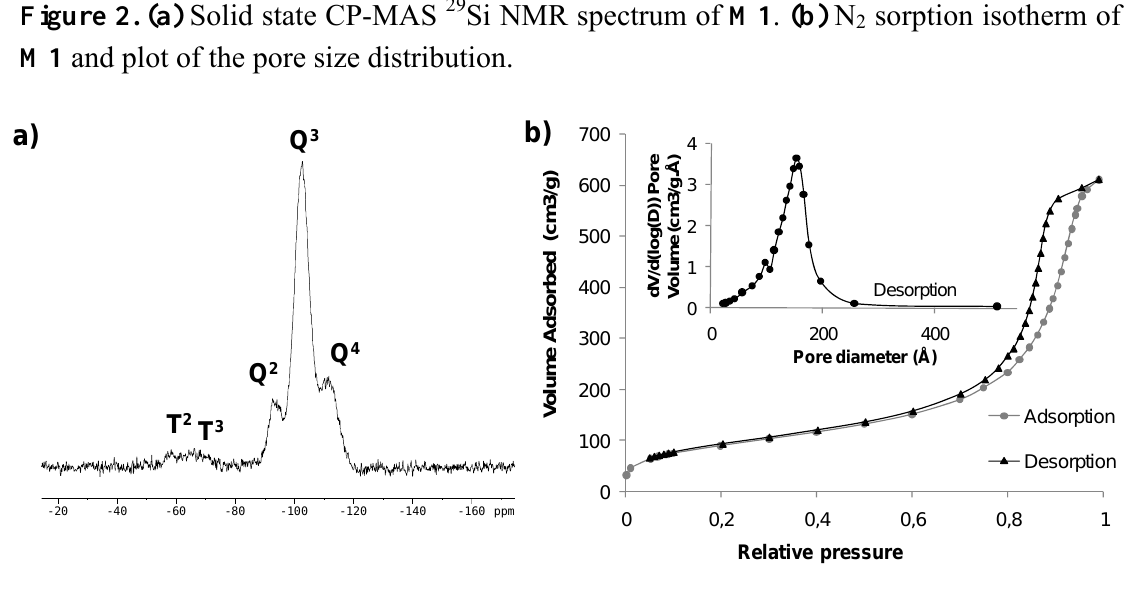
sorption isotherm of 2